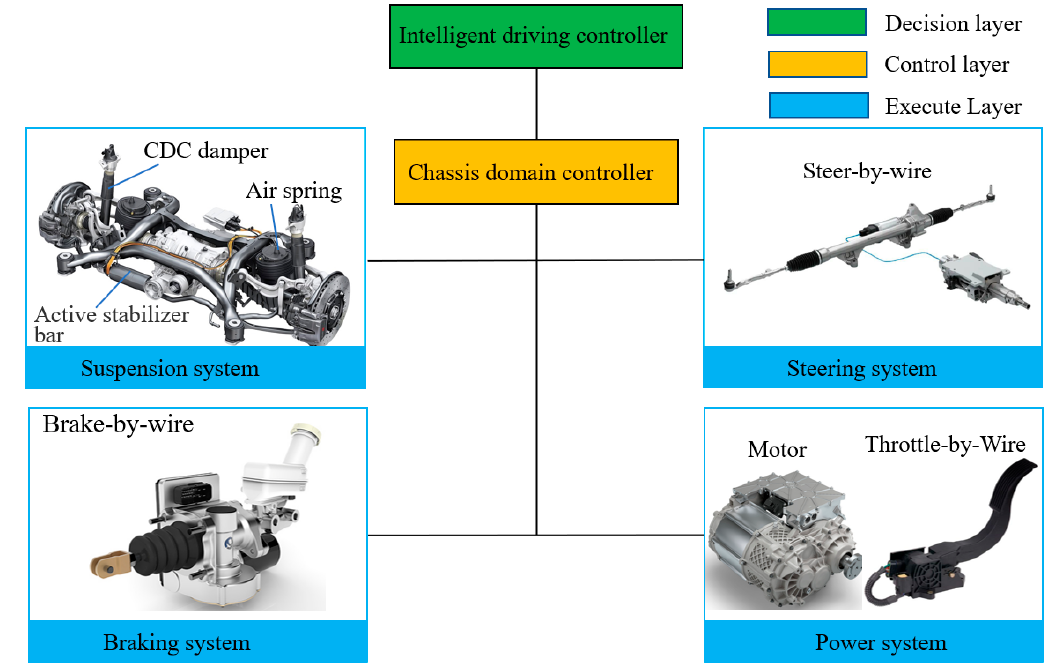
Figure 5. Chassis domain structure schematic.